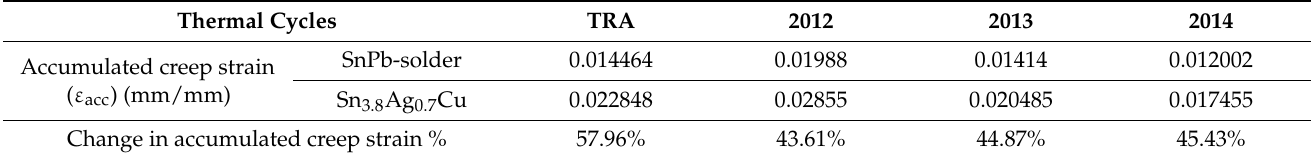
Figure 11. Accumulated creep strain damage distribution in PbSn and Pb-free solder interconnect for ( i ) 2013 and ( ii ) 2014 thermal cycles. Table 7. Percentage change in accumulated creep